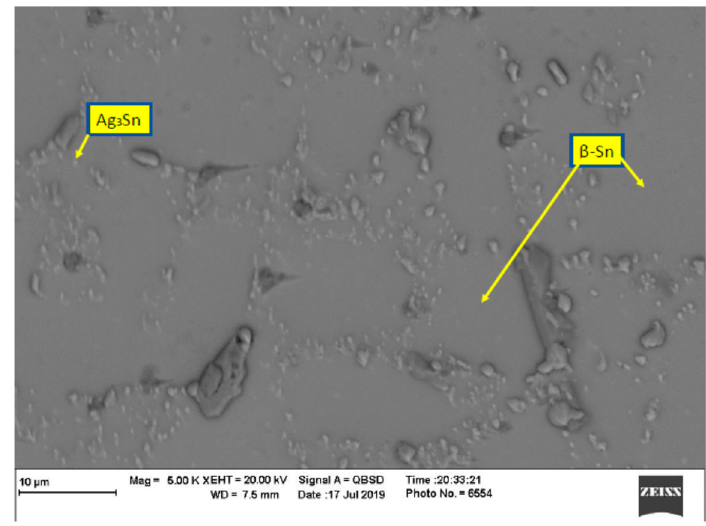
Figure 7. Microstructure of SAC305 fused to a copper pad then thermally aged at 150 °C for 100 h.